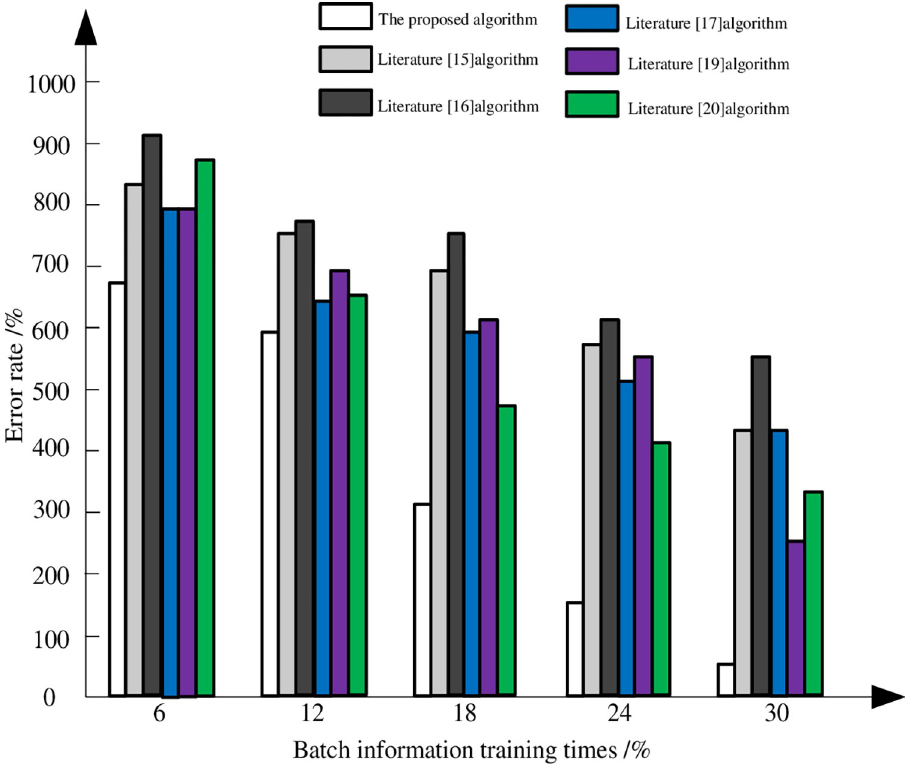
Fig 4. Comparison results of error rate of different